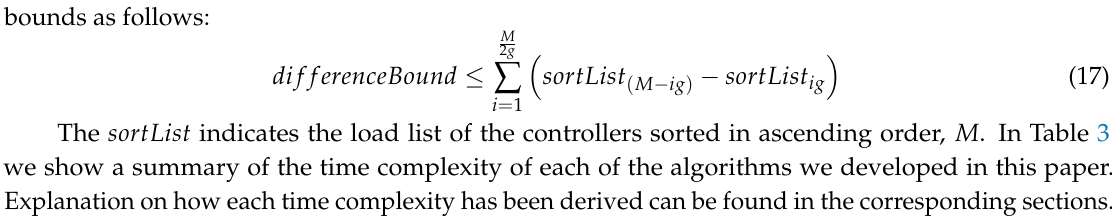
Table 3. Time Complexity of heuristics and algorithm used for Dynamic Controllers Clustering (DCC). Algorithm